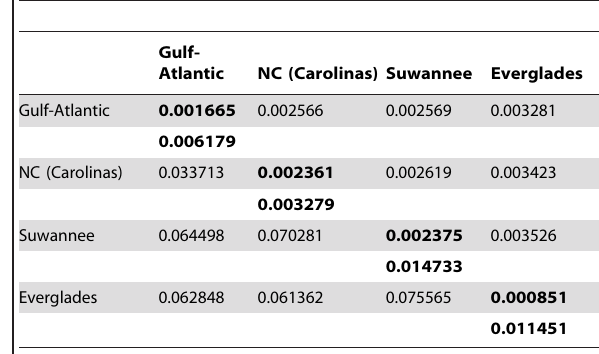
Table 4. Summary statistics for each mtDNA clade and STRUCTURAMA-inferred group.